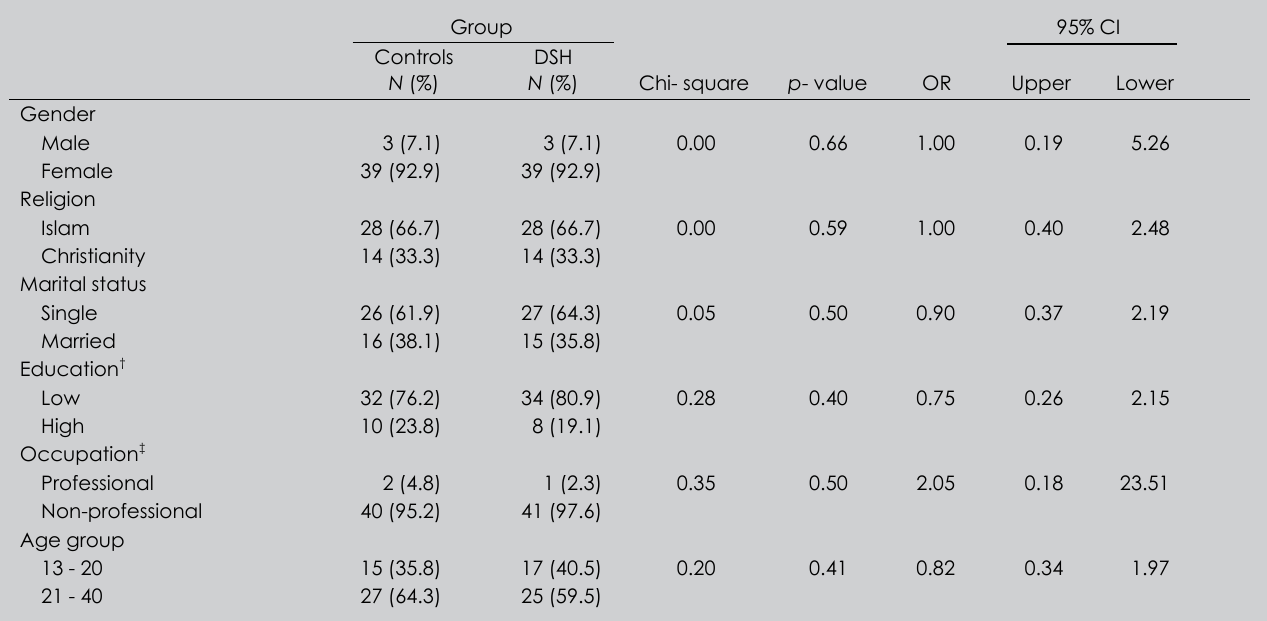
Table I. Demographic data for DSH patients and